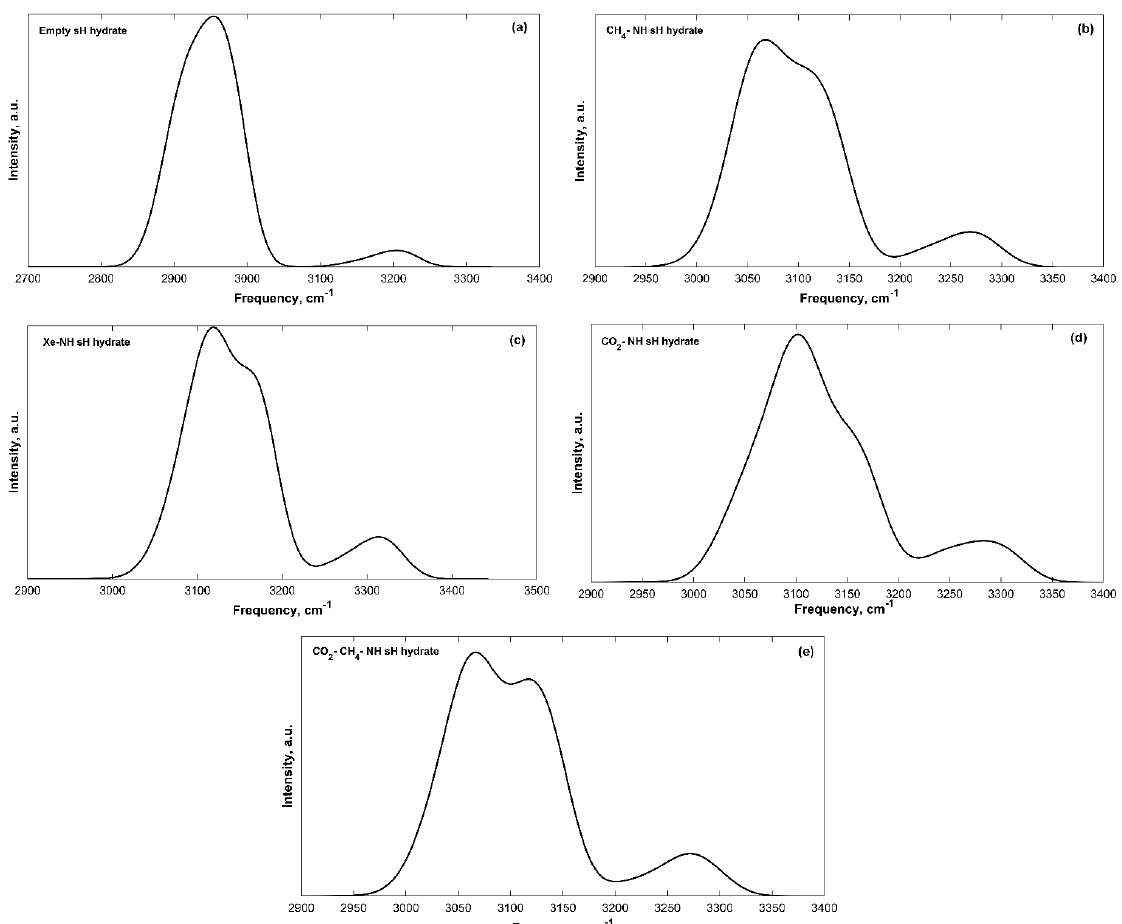
Figure 3. High frequency convoluted IR spectra bands of sH gas hydrates at 0 K and 0 GPa. ( a ) Empty sH hydrate; ( b ) CH 4 -NH sH hydrate; ( c ) Xe-NH sH hydrate; ( d ) CO 2 -NH sH hydrate; ( e ) CO 2 -CH 4 -NH sH hydrate.